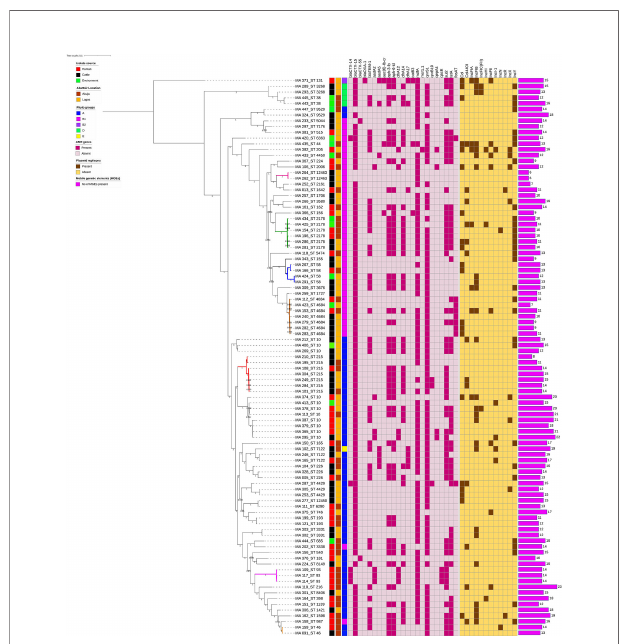
FIGURE 5 | SNP-based phylogeny of ESBL E. coli isolates from humans, cattle, and abattoir environments in Abuja and Lagos. SNP-based maximum likelihood phylogeny of E. coli isolates visualized in iterative Tree of life tool (iTol). The tree was rooted in a reference isolate E. coli strain NCTC11129. Clustering of isolates was found to be following the core genome and SNP- based phylogenies. The clustering of isolates belonging to the same phylogenetic group and sequence type was consistent. Shown for each isolate is the source: humans, cattle or environment, location, phylogroup, sequence types (STs), AMR genes and plasmid replicons, and number of